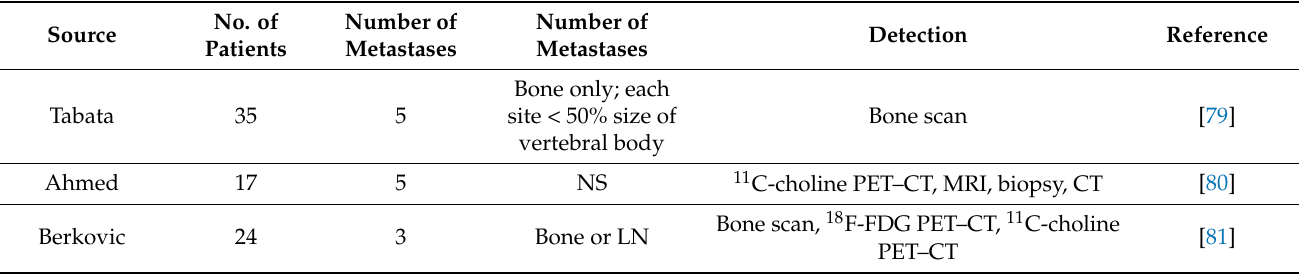
Table 3. Definition of oligometastatic prostate